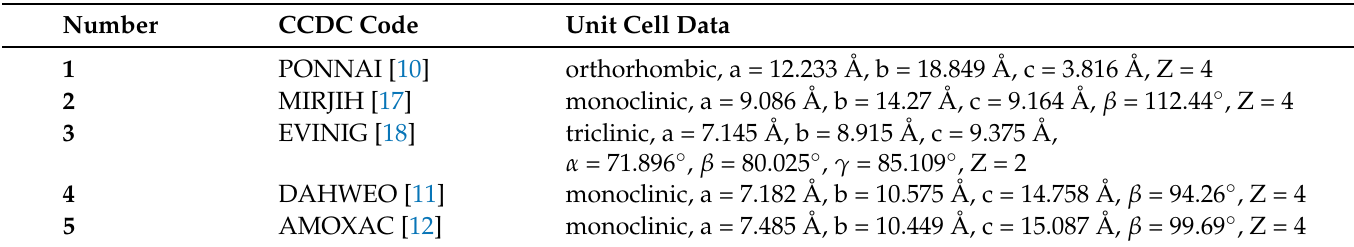
Table 1. CCDC code and unit cell data for the five studied quinolone carboxylic acid